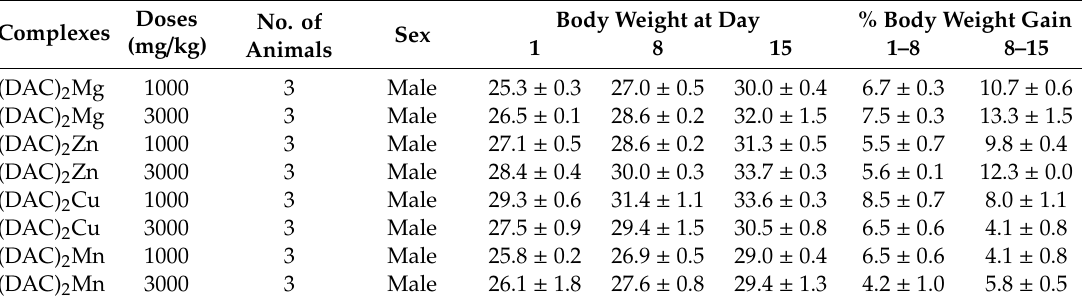
Table 10. Body weight (g) and body weight gain (%) of mice given acute oral dose (values are in mean ± SD).